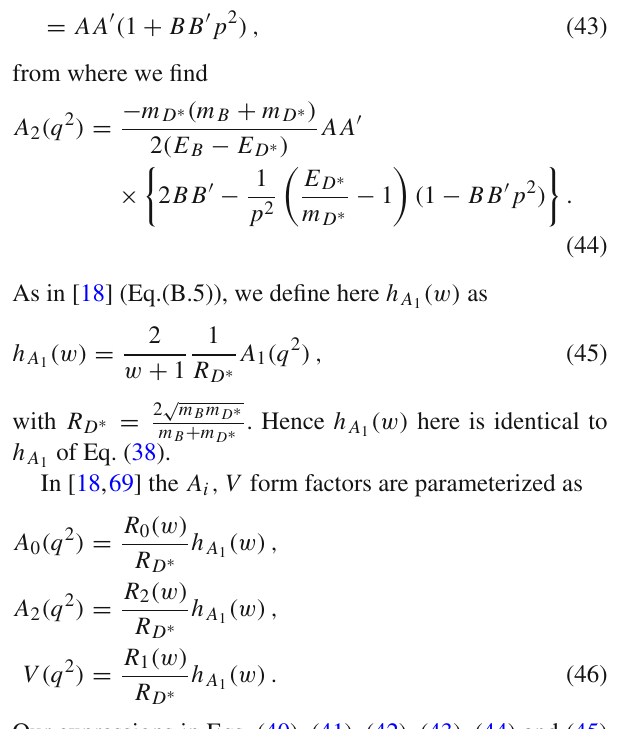
, h V and h A of Eq. (38) as a function of w normalized 1 3